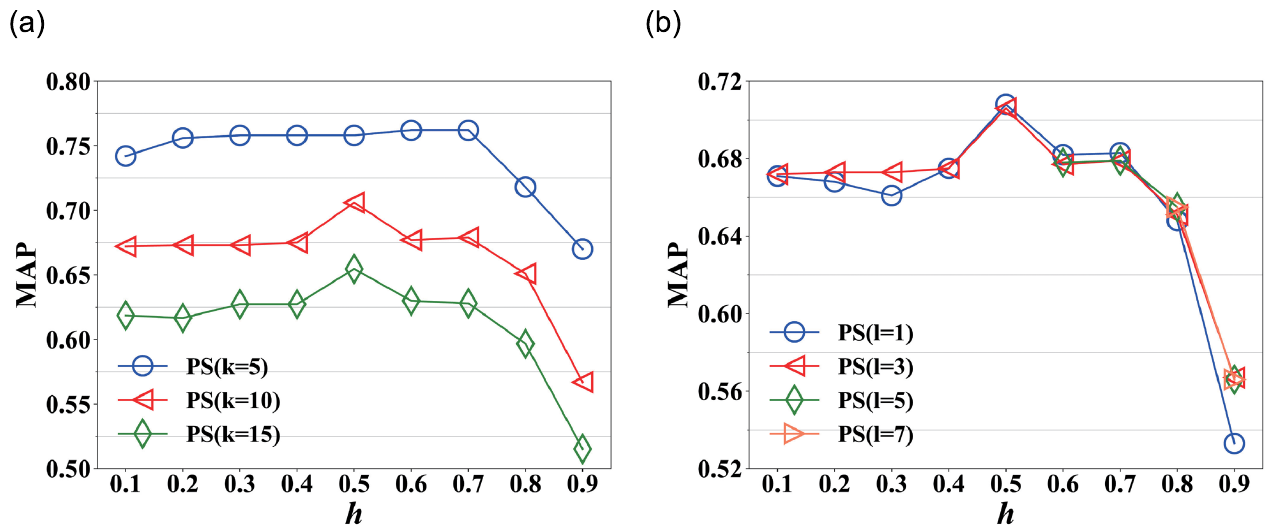
Fig 3. MAP on varying h in Nipic. (a) MAP on varying h at l = 3, (b) MAP on varying h at k = 10.